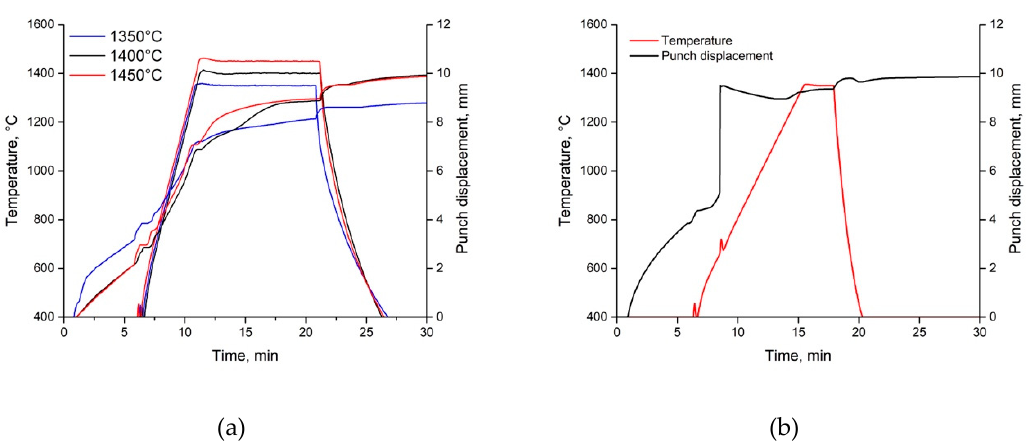
Figure 4. Punch displacement and temperature change during SPS of Ti/SiC HEBM powder at 1350, 1400 and 1450 °C and 10 min ( a ) and at 1350 °C and 2.5 min ( b ).